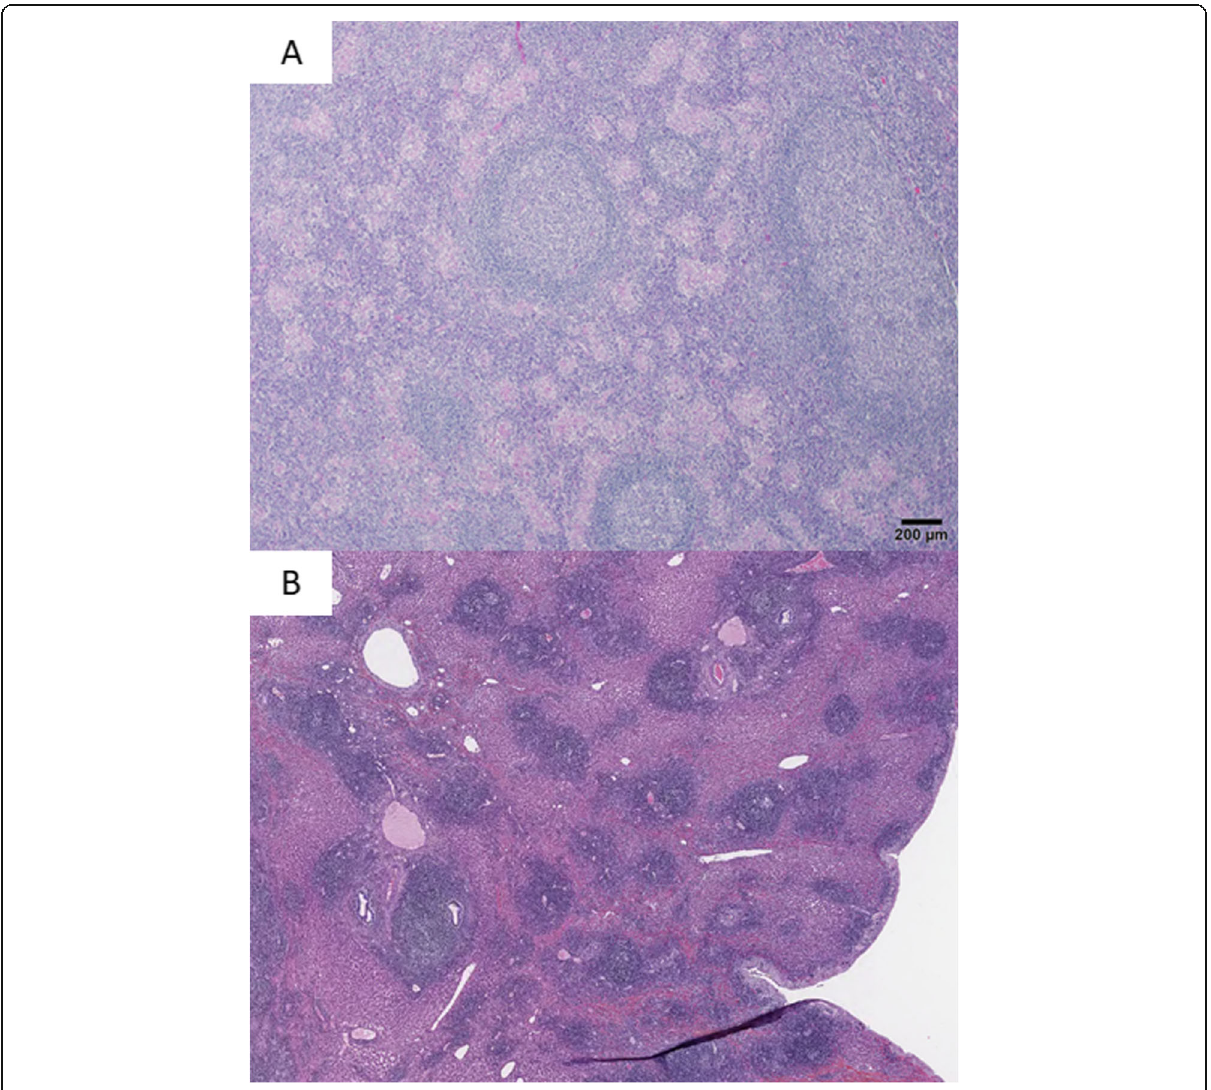
Fig. 4 Pathological examination reveals that germinal centers are present and small lymphocytes and plasma cells are infiltrating the lesion ( a ). Marked lymphoid cell infiltration in the portal tracts was observed in the perinodular lesion